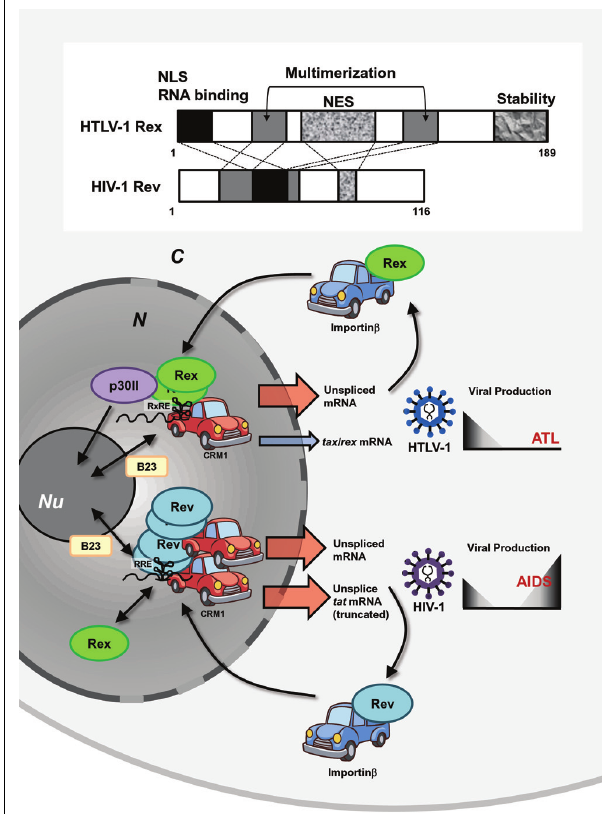
FIGURE 4 | Similarities and differences between HTLV-1 Rex and HIV-1 Rev. HTLV-1 and HIV-1 are evolutionally distinct, but both belong to a family of complex retroviruses. Both viruses encode transactivators, HTLV-1Tax and HIV-1Tat, and post-transcriptional regulators, HTLV-1 Rex and HIV-1 Rev. AlthoughTax andTat transactivate their respective LTRs, they act though different mechanisms and cannot be replaced with each other. On the other hand, even though the homology in the primary sequence of HTLV-1 Rex and HIV-1 Rev is low, they carry out similar functions through common domains, such as NES, NLS, and multimerization domains.They are RNA binding proteins and specifically bind to respective viral mRNA with high affinity through RxRE for Rex and RRE for Rev.They stabilize unspliced or partially spliced viral mRNA and actively transport them to the cytoplasm via CRM1 binding for selective translation of viral structural proteins and return to the nucleus by interactions with Importin β . Rex can function through RRE, while Rev cannot bind to RxRE. HTLV-1Tax is translated only from fully spliced viral mRNA; thus, stabilization and active nuclear transport of unspliced HTLV-1 mRNA by Rex reduces the relative expression rate ofTax. On the contrary, HIV-1 Rev does not suppressTat activity, since it enhances truncated, yet active,Tat proteins.Thus, it is expected that HTLV-1 Rex favors reduction of viral production, whereas HIV-1 Rev may support active viral production. N, nucleus; C, cytoplasm; Nu,